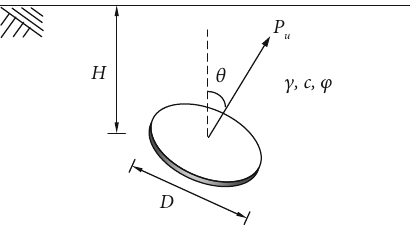
Figure 1: Problem